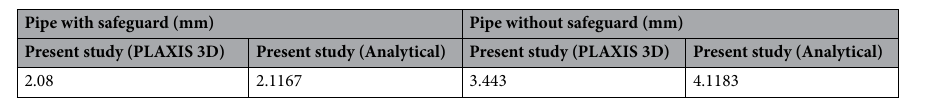
Table 4. Comparison of peak mid-span pipe